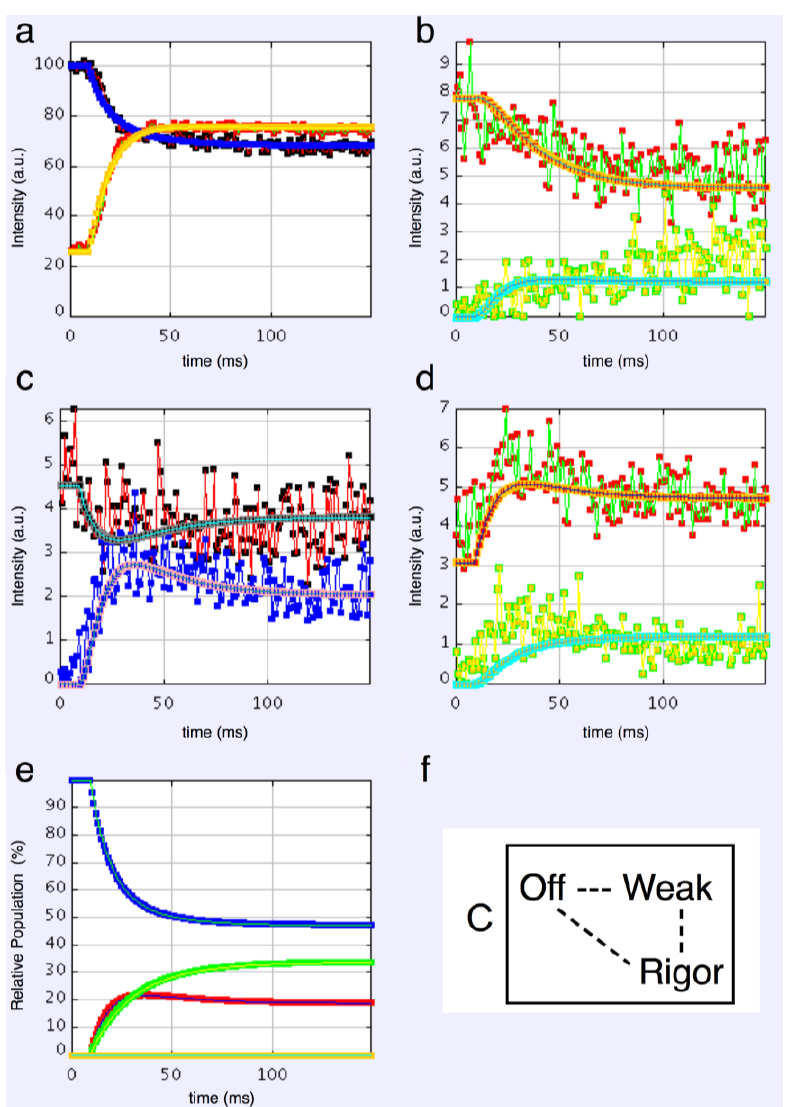
Figure 9. Plots from simulated annealing fits of the 3-state model (C in Figure 2b) to the observed equatorial time-courses in Figures 4 and 6, with SL control applied and the rigor 20 allowed to be freely fitted. The fit is good (Chi = 1240 (Table 4)), and this time there is very clear evidence of the overshoots being modelled. ( a ) Plot of the A(10) data, in black, and the fit, in blue; the A(11) data, in red, and the fit, in yellow. ( b ) Plot of the A(20) data, in red, and the fit, in orange; the A(40) data, in green, and the fit, in turquoise. ( c ) Plot of the A(21) data, in black, and the fit, in pale blue; the A(31) data, in bright blue, and the fit, in purple. ( d ) Plot of the A(30) data, in red, and the fit, in orange; the A(32) data, in green, and the fit, in turquoise. ( e ) Plot of the populations in the three states: off is blue, weak is red and rigor-like is green. The populations at the active plateau are 48% off, 20% weak and 32% rigor-like (Table 4). ( f ) The three states in model C: off, weak and rigor-like.